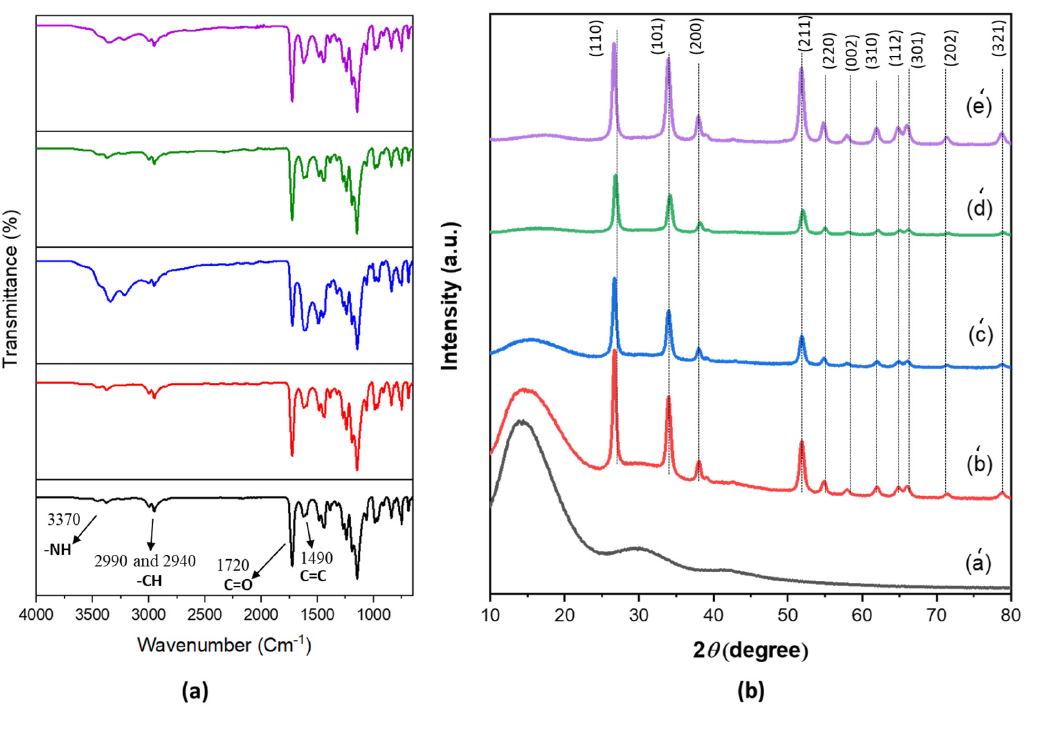
Figure 2. ( a ) FTIR spectra for pure C-PMMA and the C-PMMA/SnO 2(a–d) nanocomposites, ( b ) XRD diffraction patterns of (a’) C-PMMA, (b’) C-PMMA/SnO 2a (c’) C-PMMA/SnO 2b , (d’) C-PMMA/SnO 2c , and (e’) C-PMMA/SnO 2d .